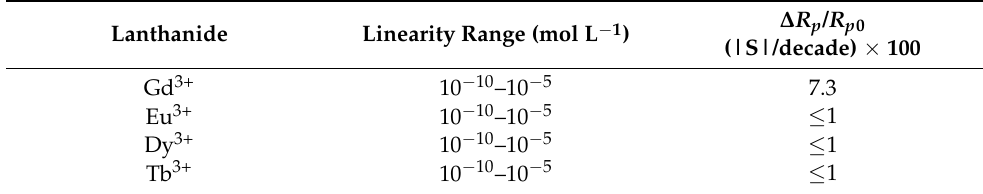
Table 3. Responses of sensors based on bis-N-MPyC films for Gd 3+ , Eu 3+ , Tb 3+ and Dy 3+ lanthanides and linear ranges.